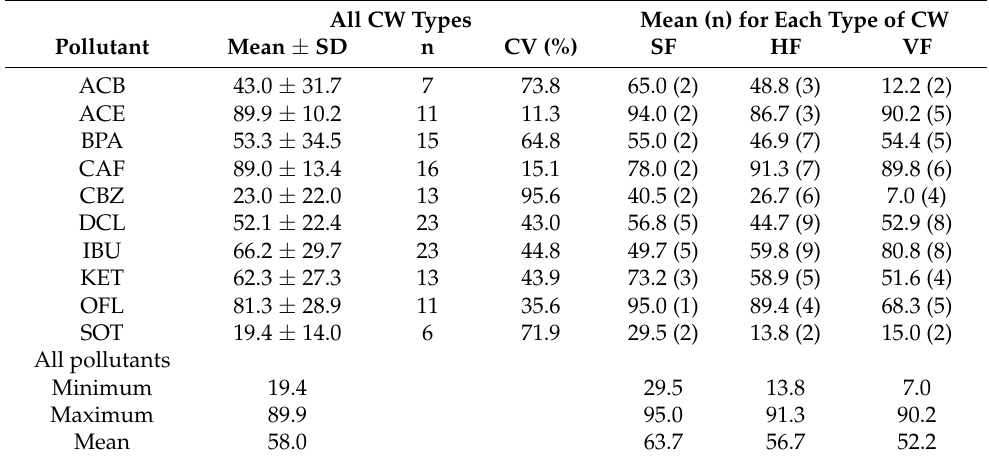
Table 3. Removal of EOC in all CW types together and separately in the different CW types.